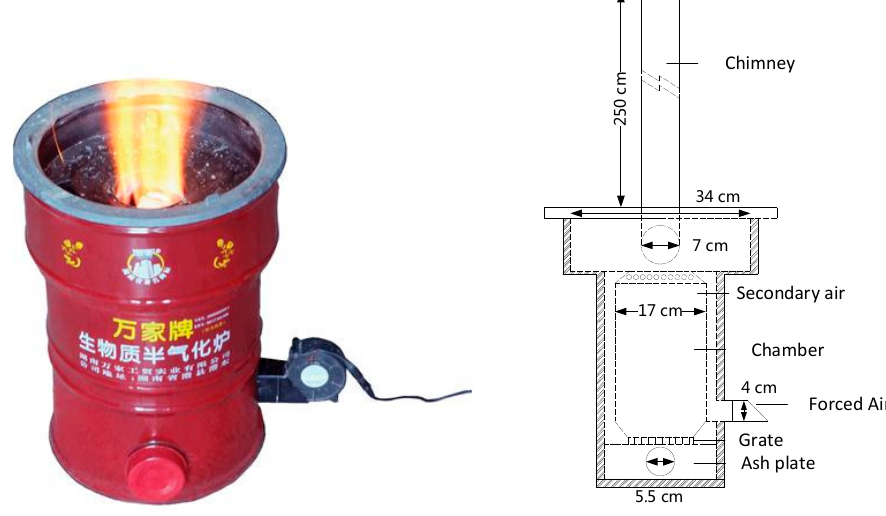
Figure 1. The stove and structure used in the current study.